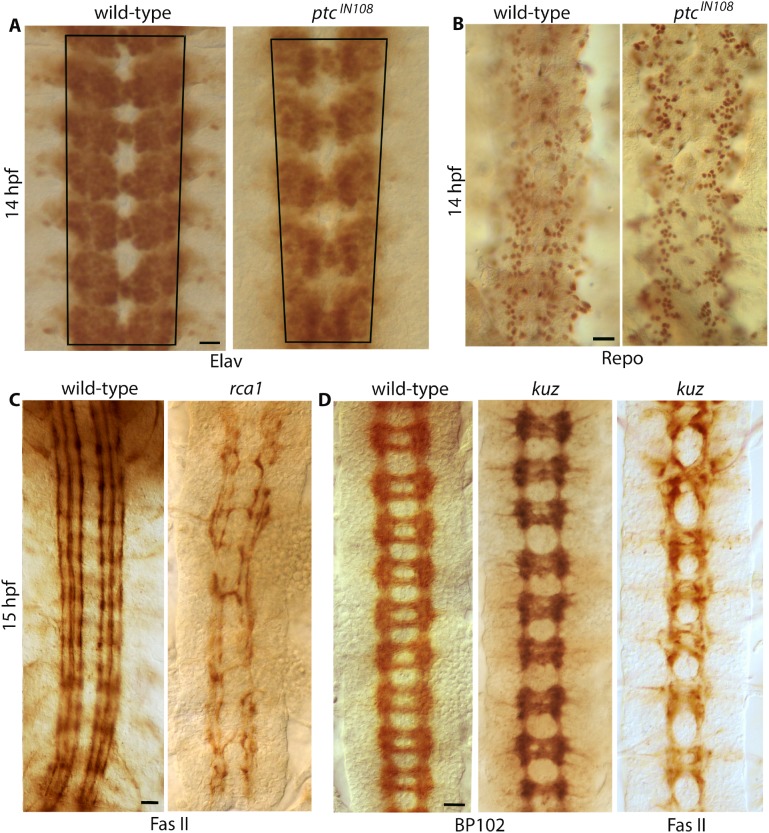
The specificity of the funneling phenotype in ptc mutant embryos.(A): Elav-stained wild-type and ptc mutant embryos. Note the funneling phenotype in the mutant. The cells in the mutant in the posterior region is much more tightly packed compared to wild-type. A decrease in neuronal number is not evident. Scale bar: 8 μm. (B): Embryos were stained for the expression of Repo, a glial marker. A decrease in glial number is not evident in the mutant. The distribution pattern of glia in the mutant reveals the funneling phenotype. Scale bar: 8 μm. (C): Fas II-stained embryos. In rca1 mutants, GMCs do not divide but adopt the fate of one of its progeny cells, thus, have a significantly reduced number of neurons. The tracts, however, do not move towards the midline, if anything, they are slightly farther apart. Scale bar: 8 μm. (D): BP102-stained wild-type and kuzbenian (kuz) mutant embryos (the first two panels) and Fas II-stained kuz mutant embryo. Note that kuz mutants have significant commissural defects, but they do not show any funneling phenotype or movement of tracts towards the midline. DAB-histochemistry was used for color development of embryo staining. Scale bar: 8 μm.